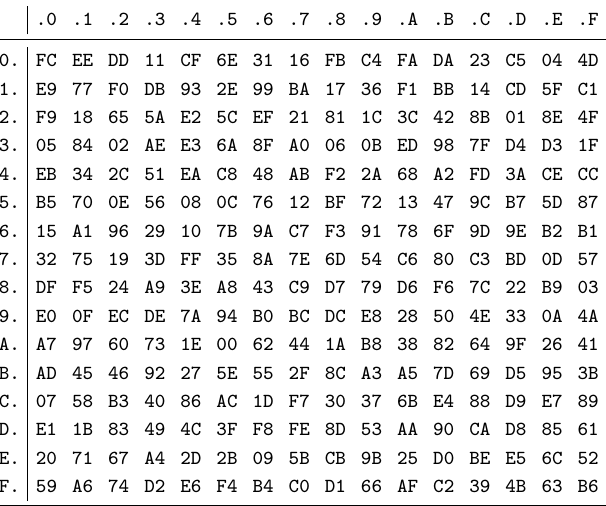
Table 2: The look-up table of 𝜋 . For example 𝜋 ( 7A ) = C6 .